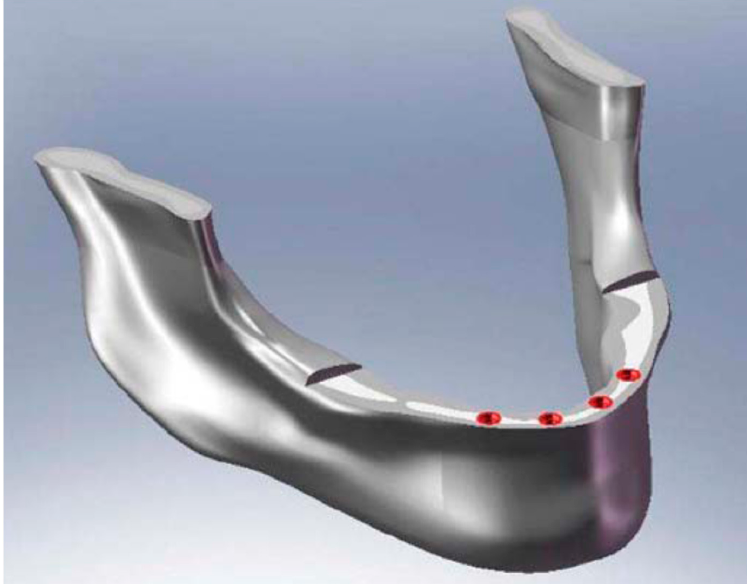
Figure 7. A mandibular 3D model of dental implant positioning in the interforamina position. This is a simple example of the ideal position of dental implants for overdenture bar prosthetic restoration.